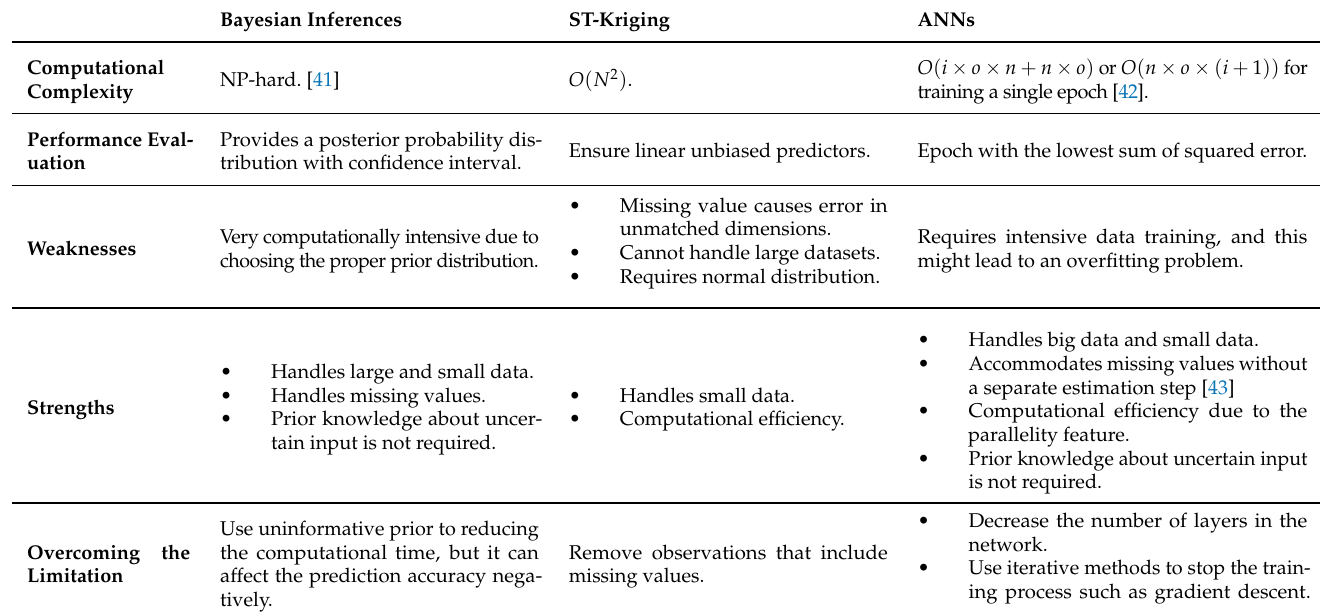
Table 1. Comparison between ST-Kriging, Bayesian inference, and